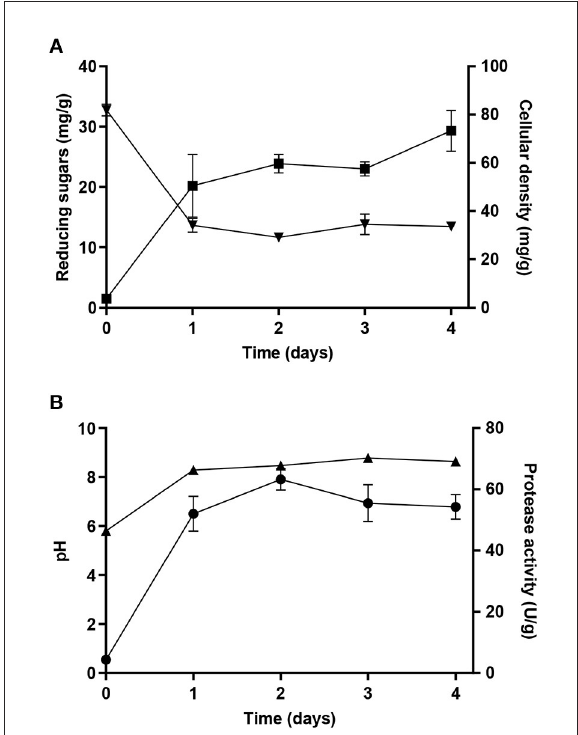
FIGURE4 (A) Cellular density ( (cid:4) ), reducing sugars concentration ( H ), (B) protease activity (•), and pH ( N ) obtained during SSF with Y. lipolytica W29 for 4 days with the optimum substrate mixture for protease